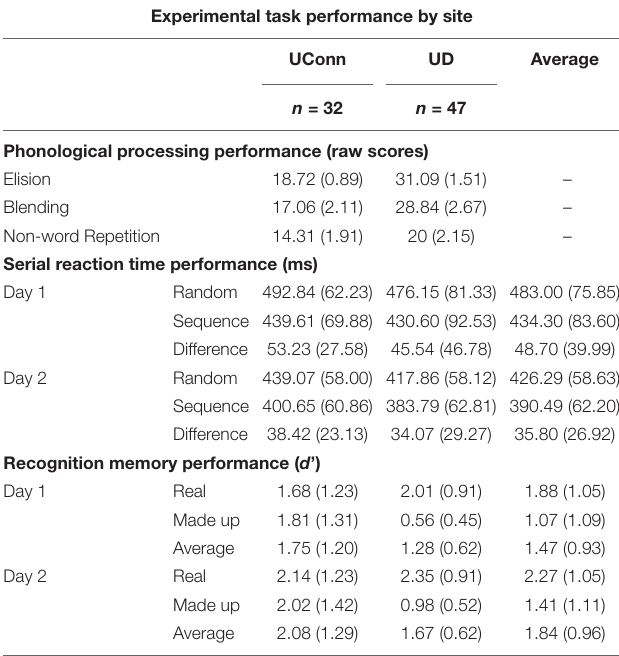
TABLE 1 | Describes the average and standard deviations of performance on outcome